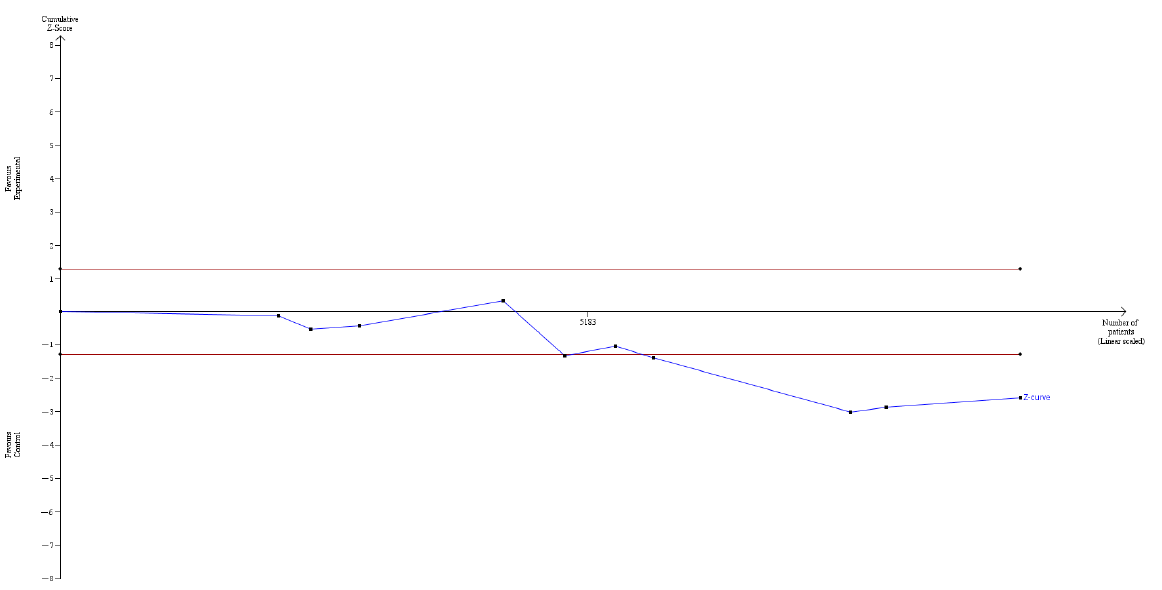
Figure 8. TSA for the number of lymph nodes harvested-z-curve ends outside the not statistically significant zone.